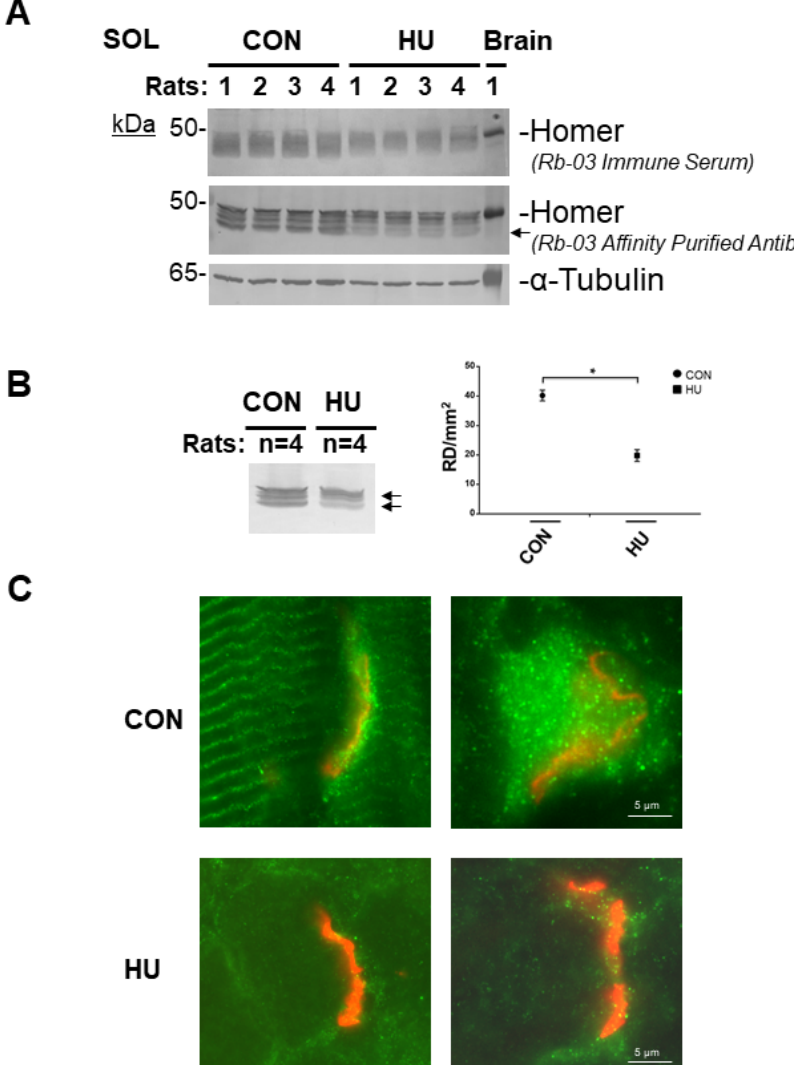
Figure 5. Homer protein expression analysis in rat SOL muscle after 3 weeks of HU. ( A ) . Western blot analysis of individual SOL muscle from ambulant (CON, n = 4) and hind limb suspended 8- week-old female Sprague Dawley rats (HU, n = 4). In reducing experimental conditions, anti-Homer antibodies identified several immunoreactive bands with an apparent molecular weight of 45 to 48 kDa; Homer predicted molecular weight. Brain was used as Homer protein positive control. α -tubulin (lower panel) was used as protein loading control. ( B ) . Left panel, Western blot analysis of pooled female Sprague Dawley rat SOL muscles from each experimental group. Right panel, Homer Densitometry (Reflexive Density, RD) analysis. Compared to CON, in HU group, after three weeks of unloading, there was approx. a 50% decrease in Homer total proteins (arrows). ( C ) . Homer immuno-epifluorescence analysis of female Sprague Dawley rat SOL NMJ of CON vs. HU. Representative merged images double-staining experiments with anti-Homer antibodies (green) and α -BTX (red) on longitudinal sections. Homer fluorescence immunoreactivity observed surrounding α -BTX-positive areas (NMJ postsynaptic microdomain) was less evident in 3-weeks HU compared to CON. In B, data are expressed as means ± SE. Statistical differences between groups were determined by unpaired t -test. * = indicates significant difference vs. CON (ANOVA p <